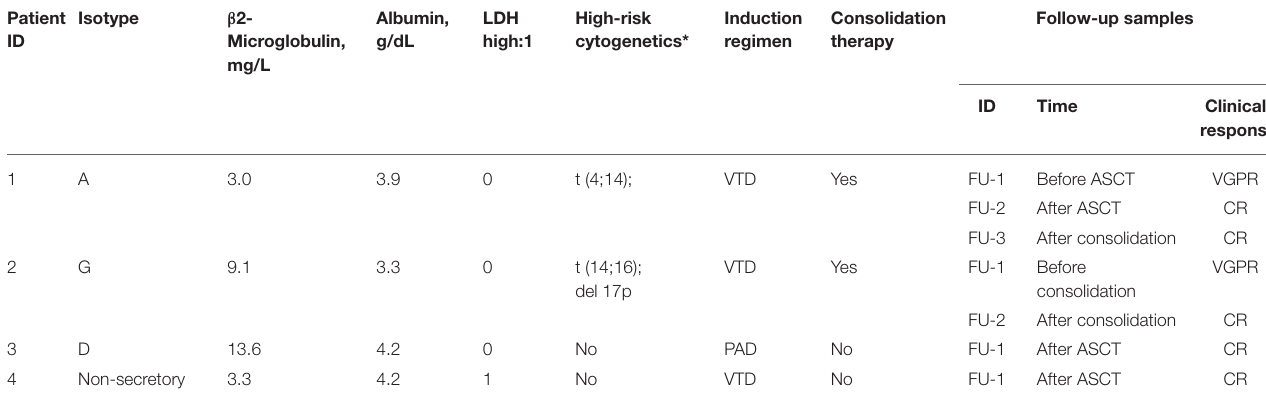
TABLE 1 | Patient and sample characteristics. Patient ID